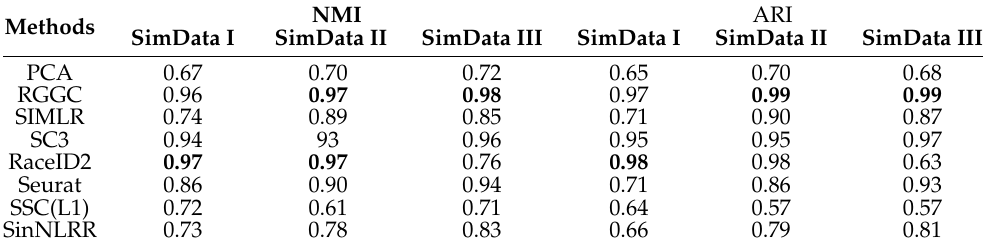
Table 2. Performance comparison of the three simulated scRNA-seq datasets with 8 different clus- tering algorithms. Detailed information of the 3 simulated data is presented in Lines 133–141 on page 6. Higher NMI and ARI values indicate better performance, and bold numbers indicate the best performance.